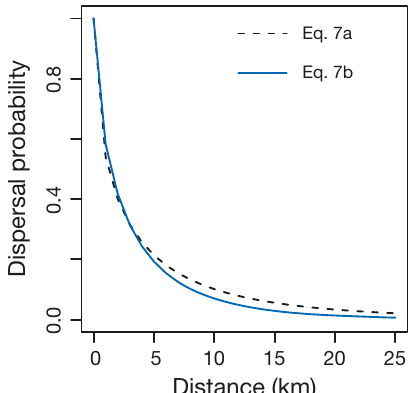
Fig. 2. Dispersal probability of salmon lice according to Aldrin et al. (2013) (black dashed line; Eq. 7a) and Aldrin et al. (2019) (blue line; Eq.